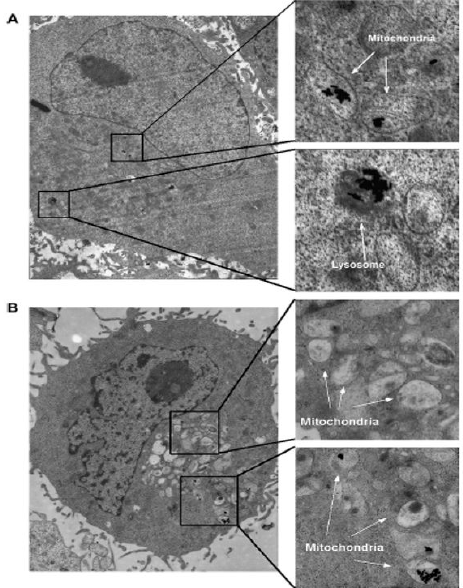
Figure 20. TEM images of ( A ) Au NRs in lysosome or mitochondria ( B ) Cells with CTAB molecules [137]. Reprinted with permission from ref. [137]. Copyright 2010